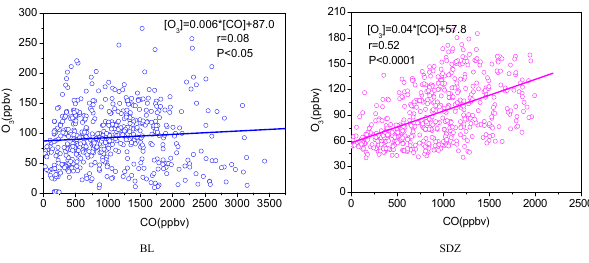
Fig. 10. Scatter plots between O 3 and CO during photochemical Fig.10. Scatter plots between O 3 and CO during photochemical active afternoon hours 2 active afternoon hours (13:00–18:00) at BL (left) and SDZ (right) (13:00 ～ 18:00) at BL (left) and SDZ(right) sites. 3 sites. of solvents are the main sources of m,p -xylene and ethyl- benzene. In contrast, isobutane and propane could be gen- erated from more diverse sources. We found that propane and isobutane have a positive correlation with isoprene (with a correlation coefficient of 0.8 for propane) during daytime at the SDZ site, indicating an important biogenic source of these two VOCs species in rural area. So the ratio of m,p - xylene-to-ethylbenzene serves better as an urban plume pho- tochemical indicator in this